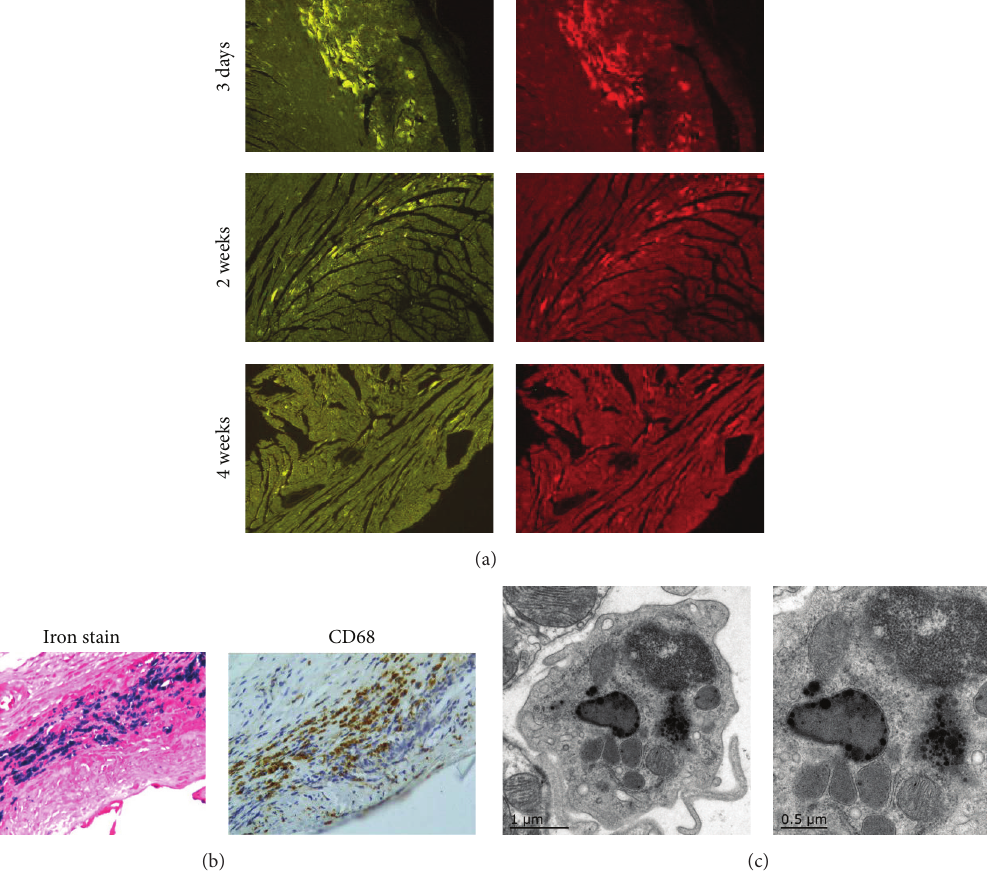
Figure 4: MSCs retention in recipient hearts. (a) The number of dual-labeled MSCs decreased over time. At 4 weeks, almost no positive cells were detected (original magnification × 50). (b) Sections stained for iron and CD68 at 4 weeks showed that most of the iron-positive cells (blue cytoplasm) were CD68-positive cardiac macrophages (brown cytoplasm) (original magnification × 200). (c) Representative electron micrographs demonstrated MPIOs engulfment inside a macrophage.